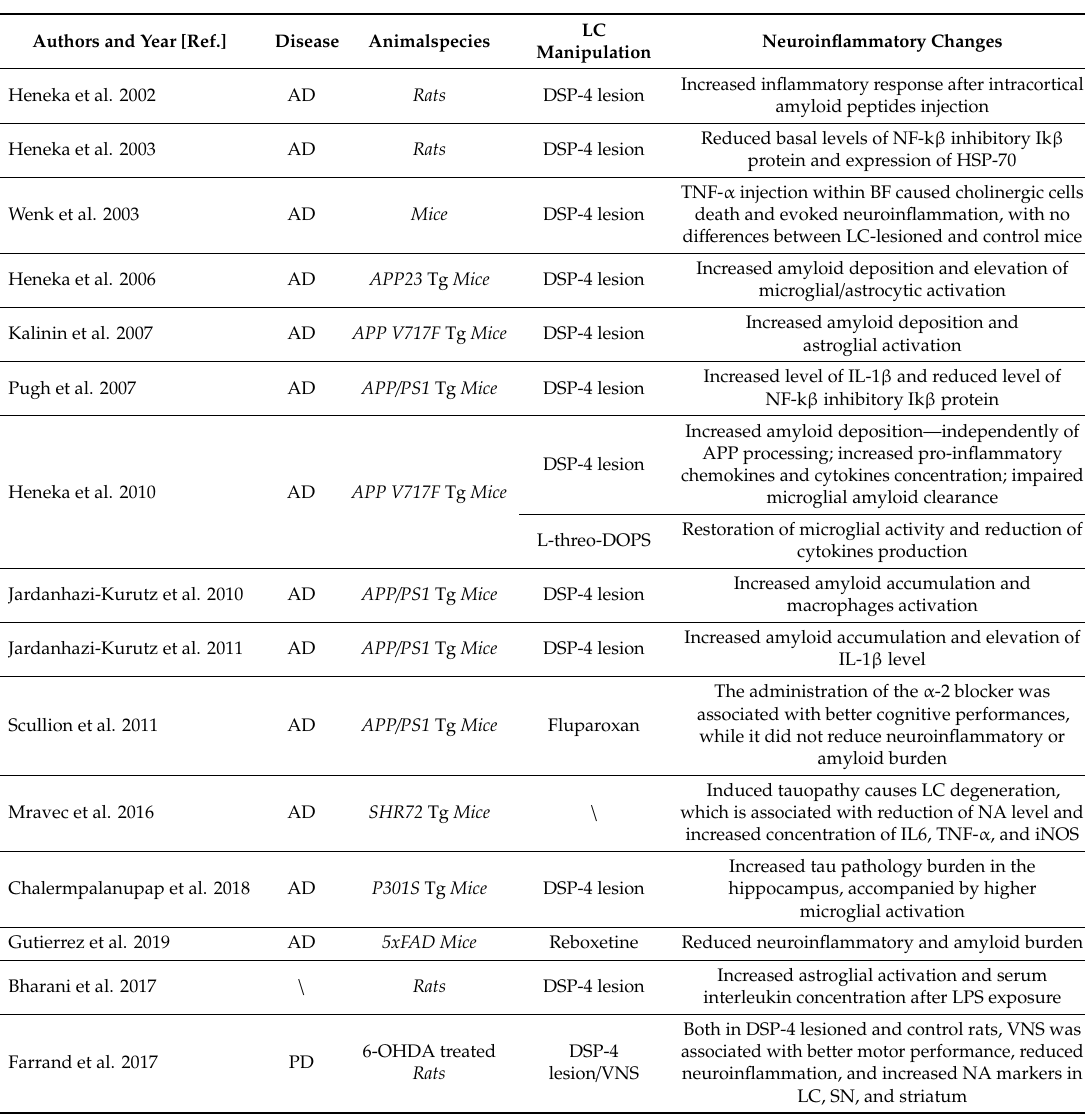
Table 1. Experimental evidences for a role of Locus Coeruleus in neuroinflammatory changes occurring in Parkinson’s disease and Alzheimer’s